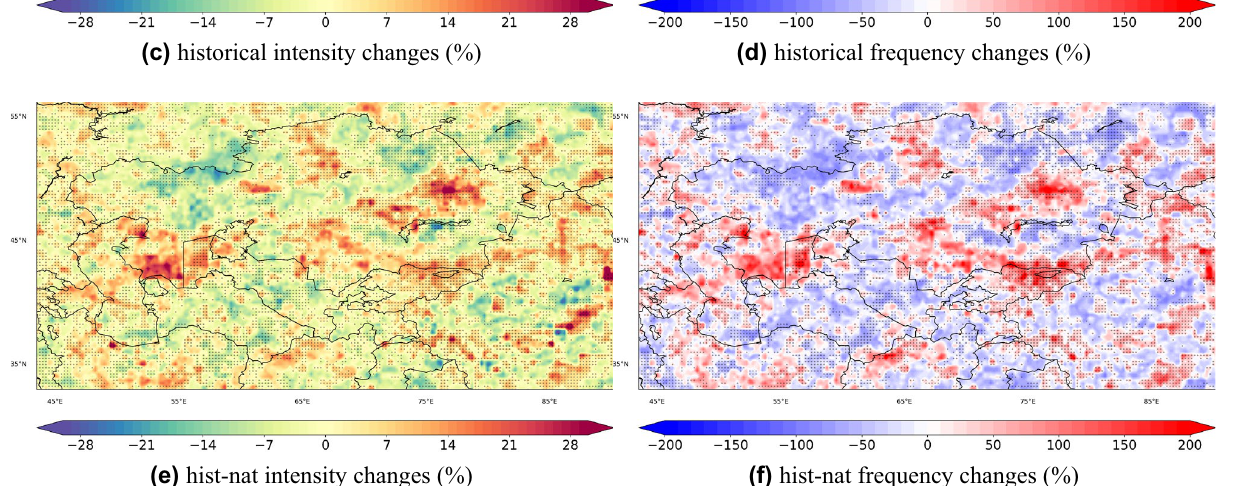
th total daily th happens on